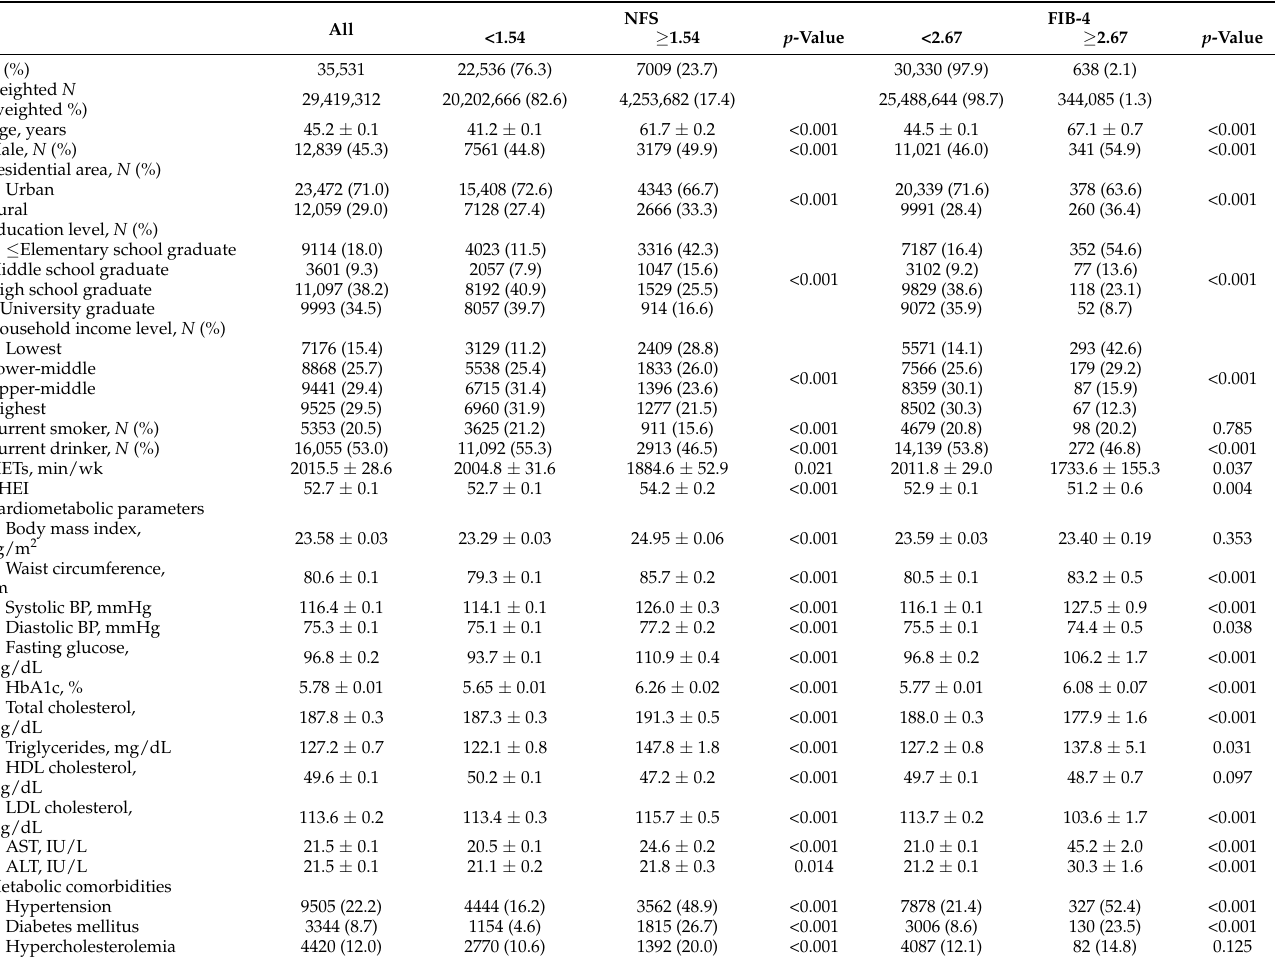
Table 1. Baseline characteristics of the study participants with or without advanced liver